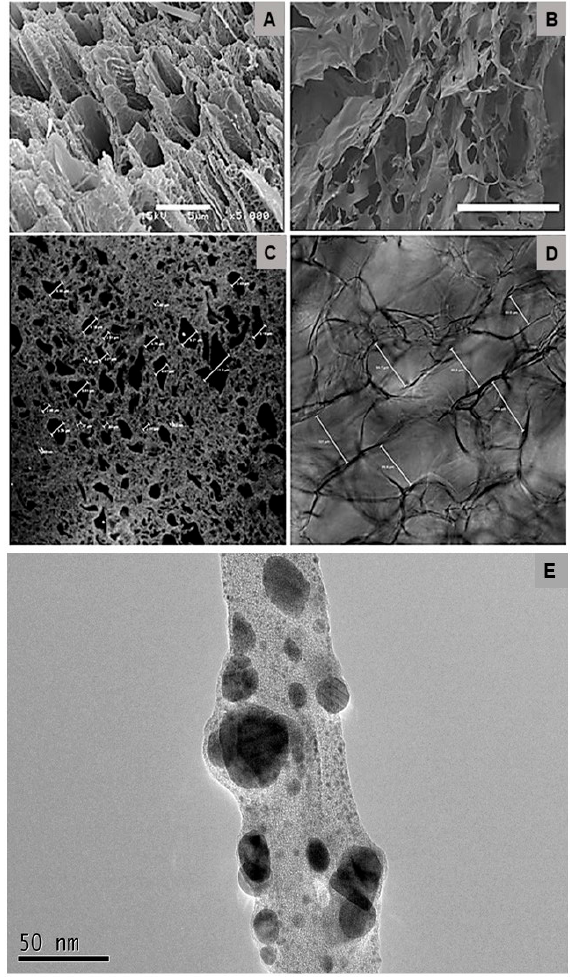
Figure 2. PVA (left) and col-HA (right) observed by SEM ( A , C ) and LSCM ( B , D ). HR-TEM observa- tion of AgNP dispersed in Formvar coated Cu-grids ( E ). SEM bars represent 5 ( A ) and 100 µ m ( B ). The assorted bars in LSCM depict the measurements made in samples, which varied from an average of 1 to 11 µ m in PVA and 60 to 100 µ m in col-HA.